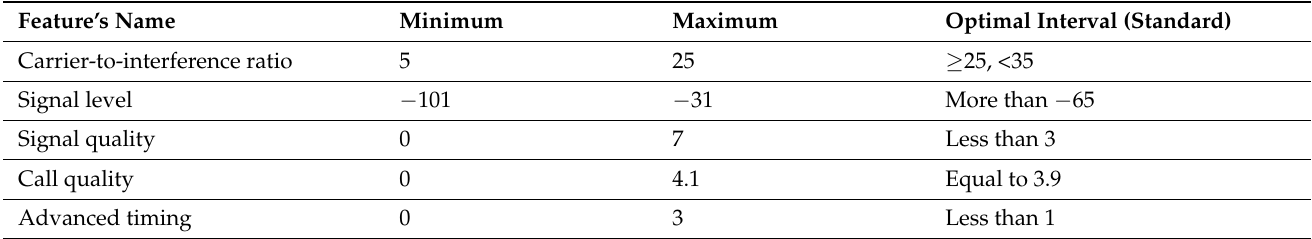
Table 5. A summary of the statistical information of the used features.